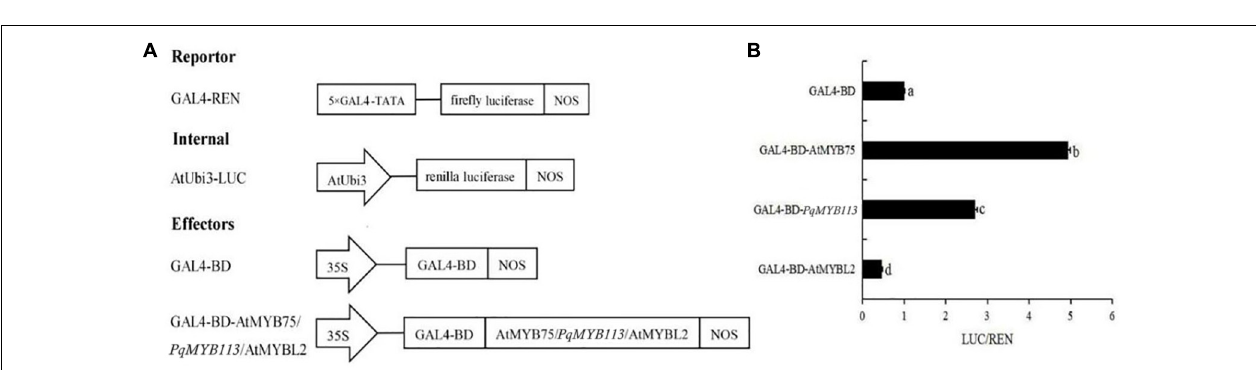
FIGURE 4 | The subcellular localization of GFP fusion of PqMYB113. Onion epidermal cells transiently expressing GFP and PqMYB113-GFP under the control of the CaMV 35S promoter. PI-RFP, mCherry fluorescence; GFP, GFP fluorescence; Merge, merged images of mCherry fluorescence; GFP fluorescence and bright-field microscopy. Bars = 33 µ m.